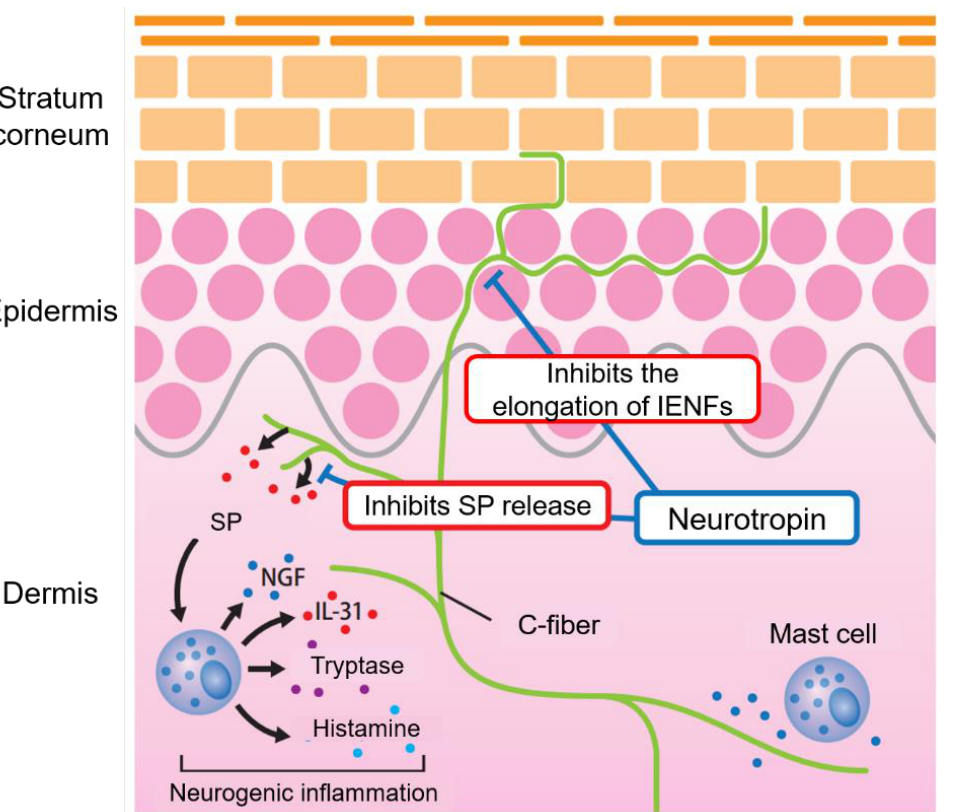
Figure 1. Antipruritic mechanism of NTP for intractable itch in AD. NTP inhibits SP release from nerve endings, which presumably suppresses neurogenic inflammation caused by nerve-SP-mast cells. In addition, NTP inhibits the elongation of IENFs and reduces itch hypersensitivity.